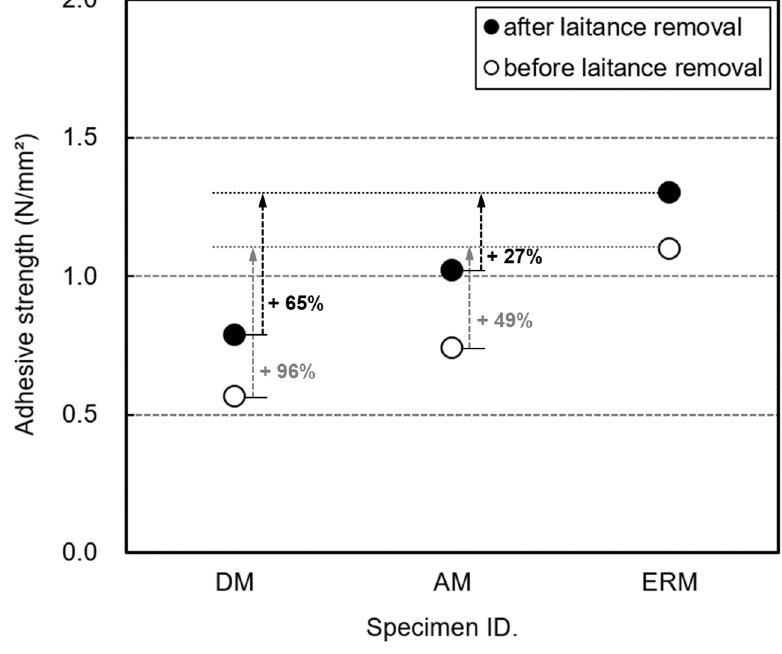
Figure 15. Adhesive strength of the porcelain tiles based on the laitance of concrete.